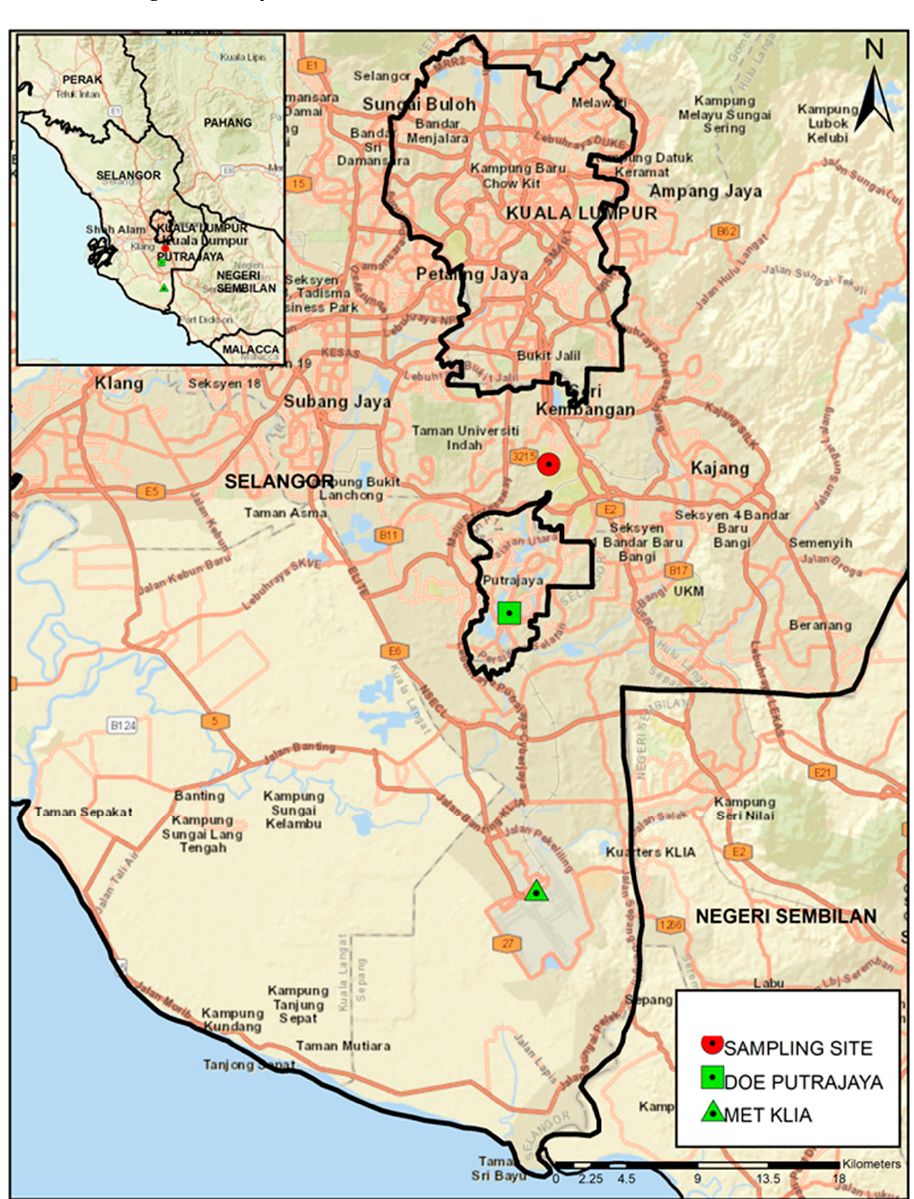
Figure 1. Location of the monitoring site, marked as a red circle, in the Klang Valley, 28 km southeast of central Kuala Lumpur, Malaysia. The government air monitoring station for PM 2.5 and NO 2 (DOE PUTRAJAYA) and meteorology station (MET KLIA) are respectively marked as a green rectangle and a green triangle. (Source: ESRI).